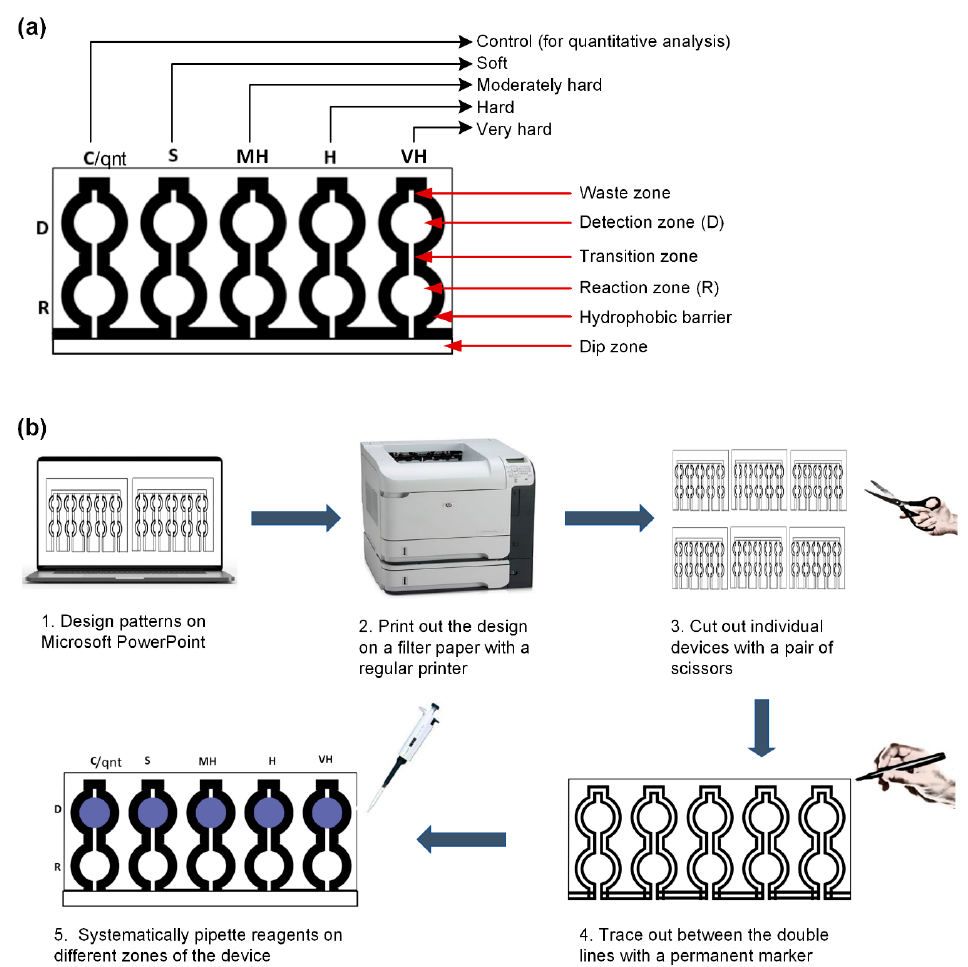
Figure 2. The paper-based analytical device’s design and fabrication. ( a ) Schematic diagram of the lateral flow dip-and-read paper-based analytical device (D: detection; R: reaction; C: control; S: soft; MH: moderately hard; H: hard; VH: very hard). ( b ) Fabrication steps and procedures for the lateral flow dip-and-read paper-based analytical device.